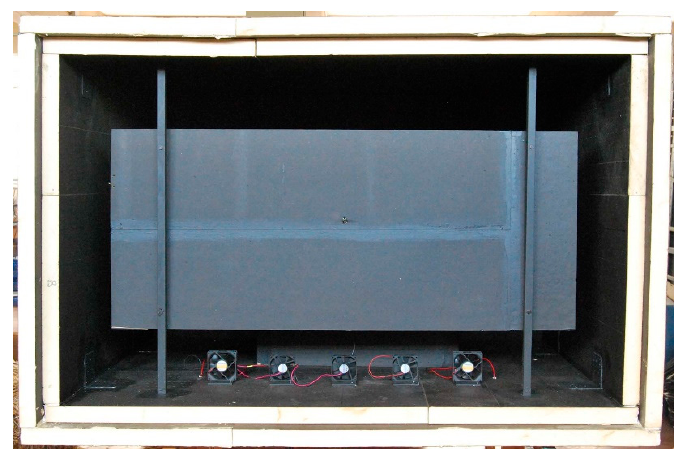
Figure 4. The MC inner front view.